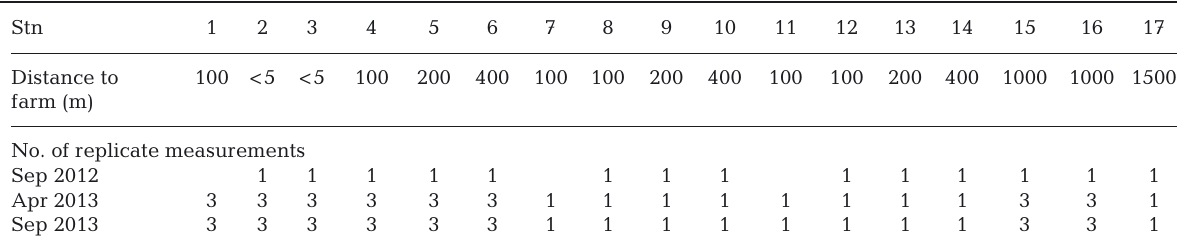
Table 1. Experimental set-up for the systematic water sampling campaign. Farm = Stns 2 and 3, ref = Stns 15–17, see Fig. 1C,D for the station survey